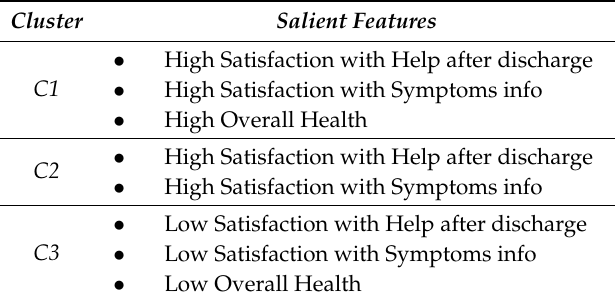
Table 8. Salient features of clusters in the first